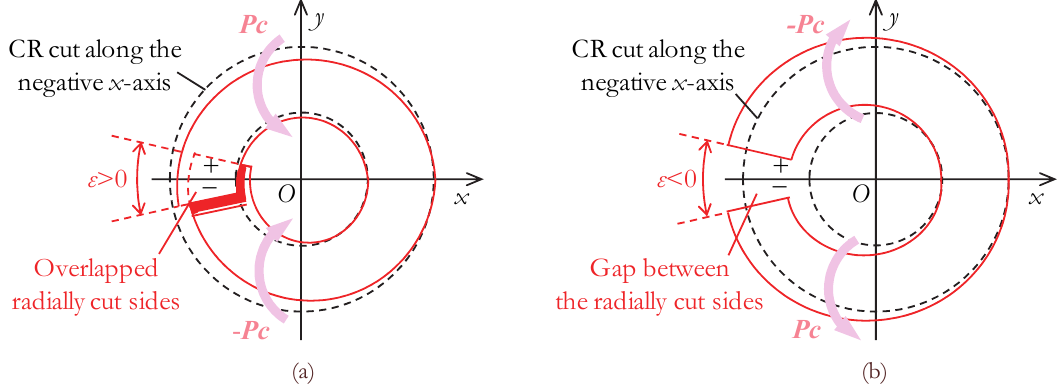
Figure 3: The nature of the ε -dislocation and the resulting couples for (a) positive and (b) negative values. between the sides of the cut, dictated by the values of ε , α and β and stresses will be developed within the cut CR, even in case of zero external forces. These stresses, due to ε , α and β (and not due to the application of some external loading scheme), are of particular interest in this study and will actually provide the stress field in the NCSR-configuration and in turn in the CSR-specimen in question, at least